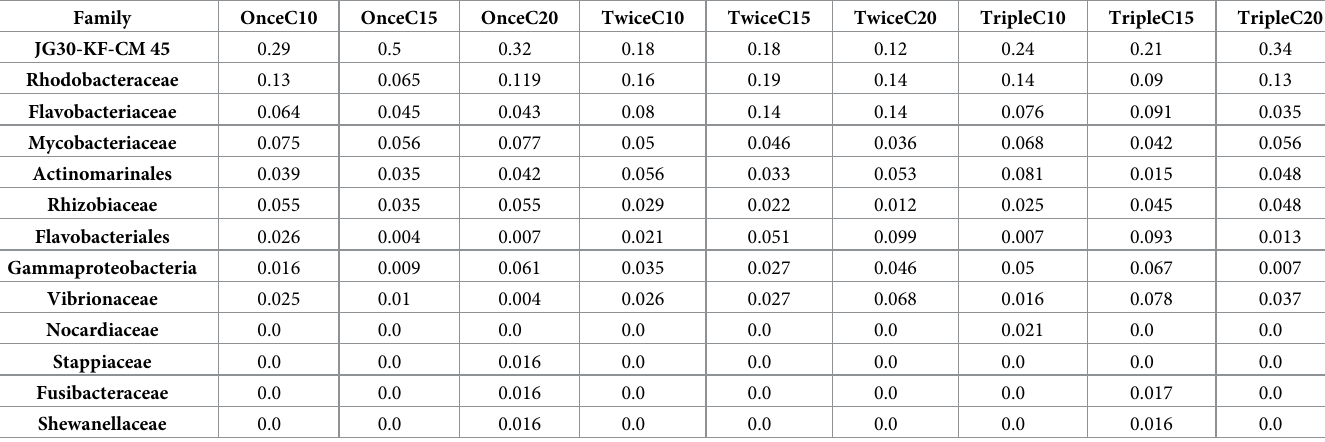
Table 6. Relative abundance of the most prevalent bacterial families identified in the intestine of Litopenaeus vannamei reared in